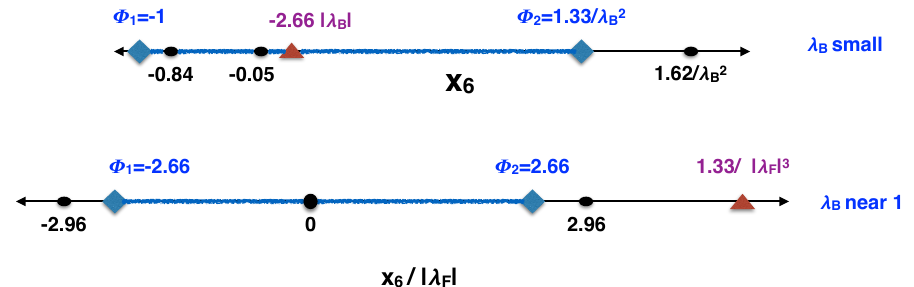
Figure 10. A sketch of the x 6 axis at small plotted the three (cid:12)xed points of the renormalization group as black dots, (cid:30) 1 and (cid:30) 2 as blue diamonds (see (4.11) for de(cid:12)nition of (cid:30) 1 and (cid:30) 2 ), and the end point of SUSY RG (cid:13)ows (discussed in the next section) as a red triangle. Region between (cid:30) 1 and (cid:30) 2 is shaded with blue color line. In the case of small (cid:21) B the (cid:12)xed points of the RG (cid:13)ow are listed in (3.58), (cid:30) 1 = j j end point of the SUSY RG (cid:13)ow occurs at (cid:13)ow are listed in (3.66), (cid:30) 1 and (cid:30) 2 are 2 at 4 = (3 (cid:21) F j j